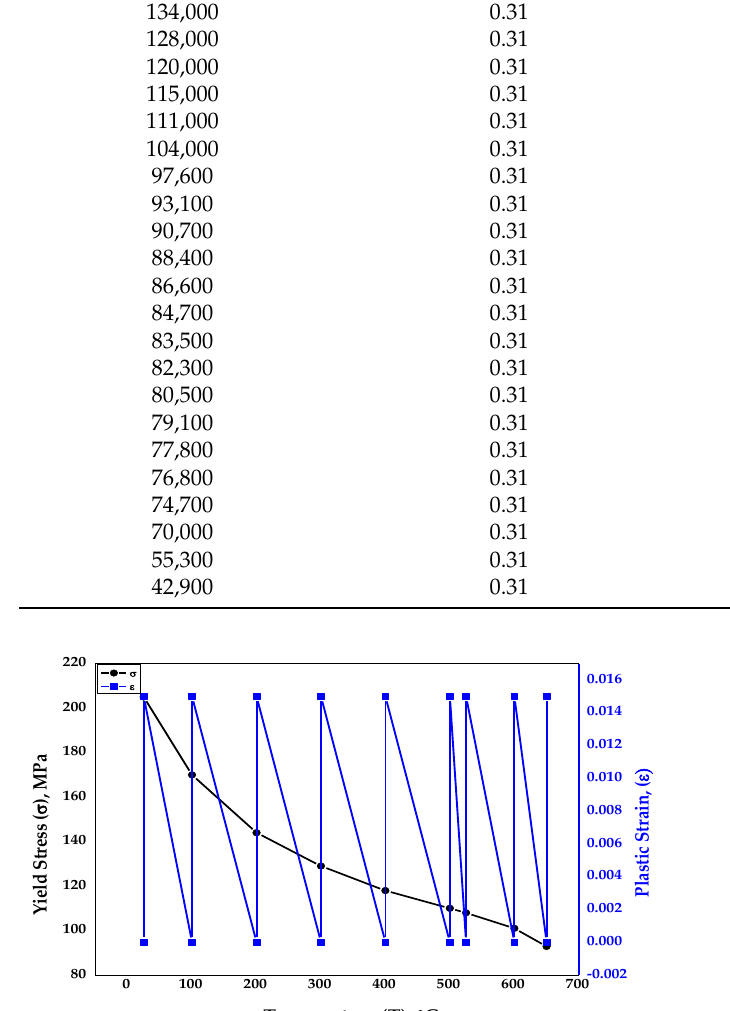
Table 2. Physical properties for SS-316 at selected temperatures [44].